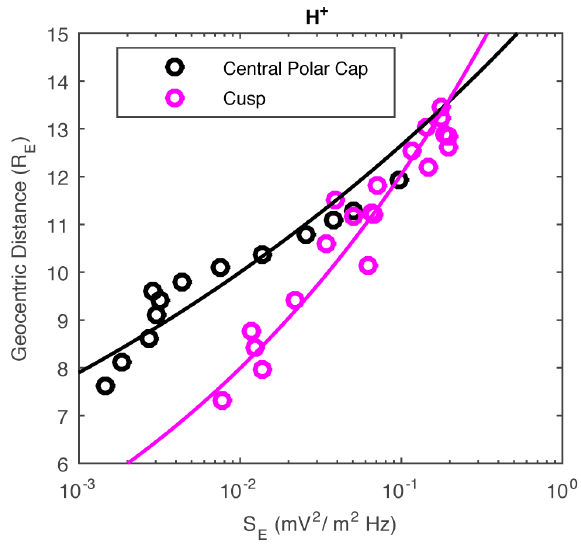
Figure 1. H + observed electric field spectral densities [(mV/m) 2 /Hz] at different geocentric distances [R ] are shown by circles for the E central polar cap (black) and cusp (magneta). Power law fits to the data are shown with solid